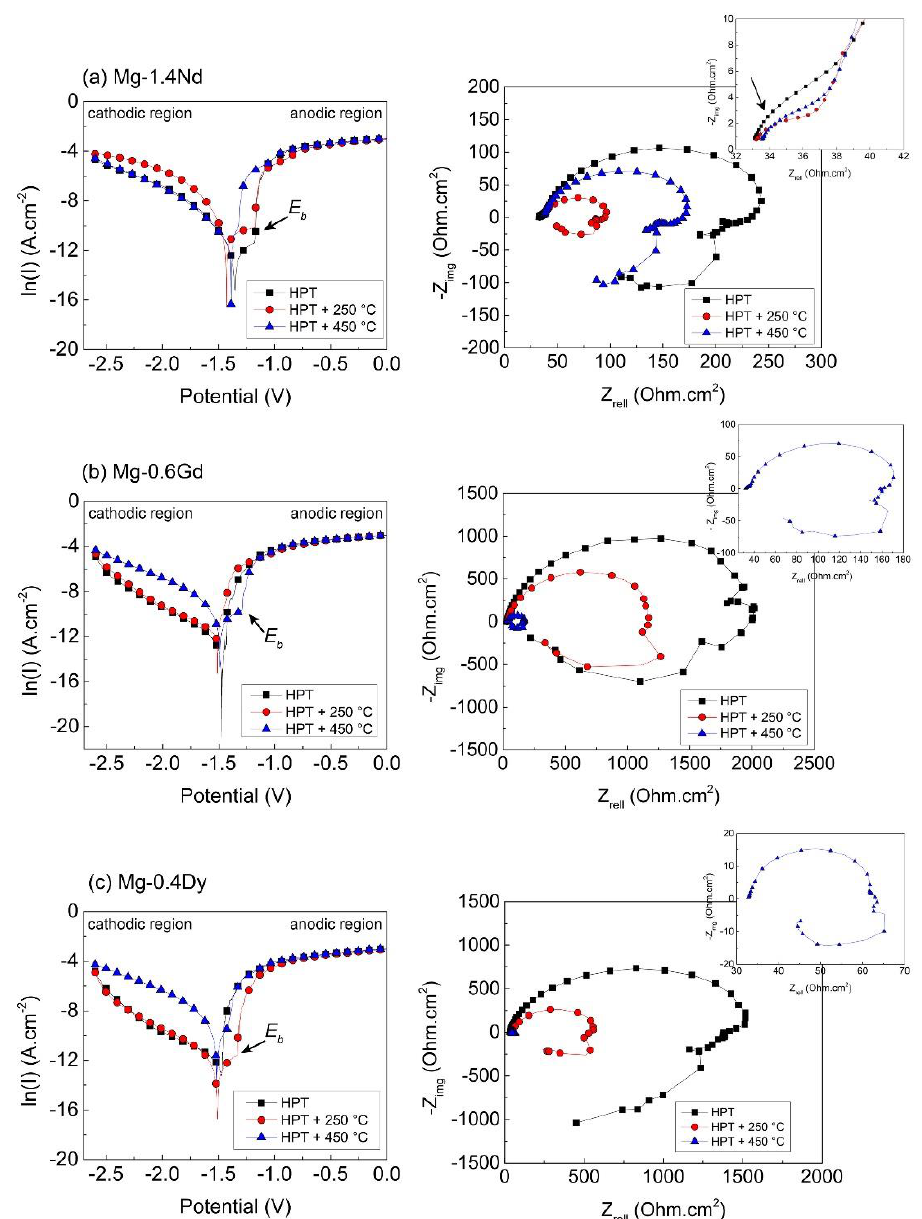
Figure 7. Polarisation curves and Nyquist plots in a 3.5% NaCl solution of deformed and recrystallised samples of: ( a ) Mg-1.4Nd, ( b ) Mg-0.6Gd, and ( c ) Mg-0.4Dy alloys. The Nyquist plots of the HPT-processed and annealed Mg-1.4Nd (250 and 450 °C), annealed Mg-0.6Gd at 450 °C, and Mg-0.4Dy at 450 °C are placed at the upper right with a small scale for further visibility.